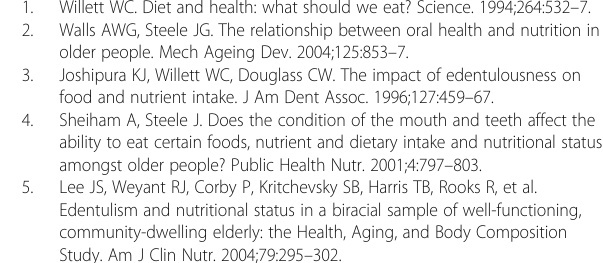
Table S2. Adjusted means of nutrient intake by the number of teeth (brackets contain 95% confidence intervals). (DOCX 47 kb) Abbreviations JPY: Japanese yen; MUFA: Mono-unsaturated fatty acids; NIPPON DATA2010: National Integrated Project for Prospective Observation of Non- communicable Disease and its Trends in the Aged 2010; PUFA: Poly- unsaturated fatty acids; SES: Socioeconomic status; SFA: Saturated fatty